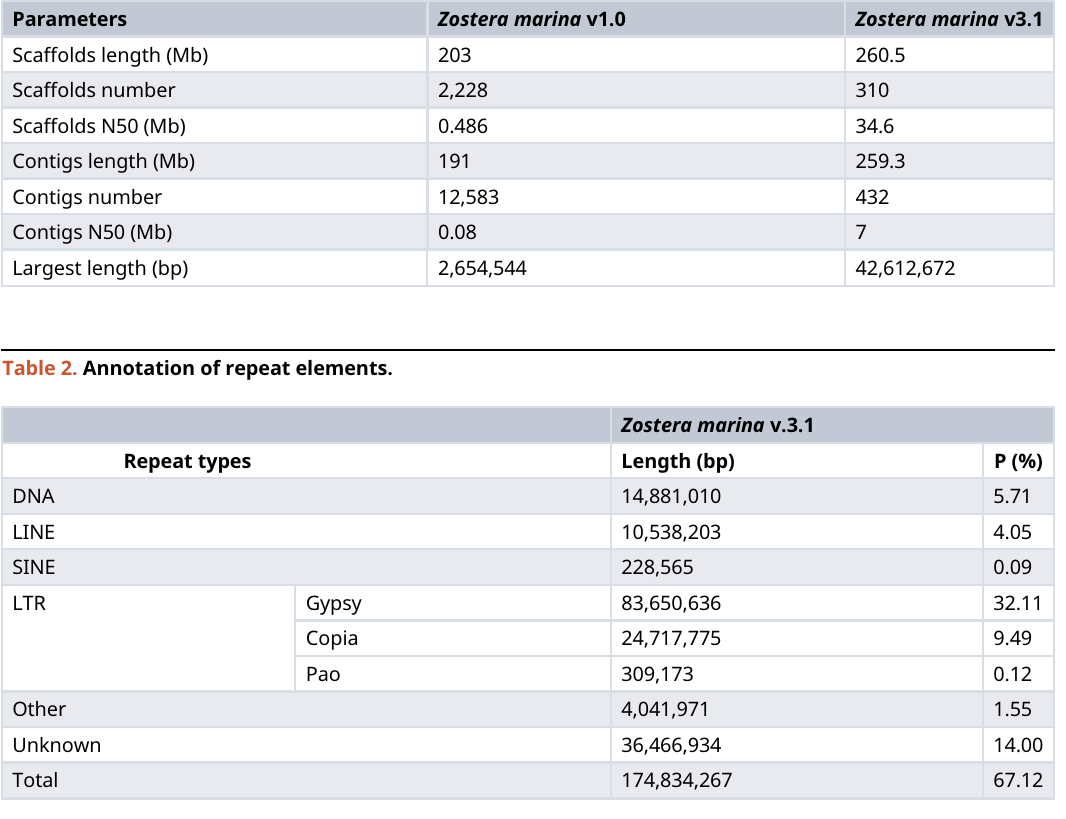
Table1.Comparisonofgenomeassembliesfor Zosteramarina v1.0(Olsenetal.,2016)andv3.1(currentstudy).